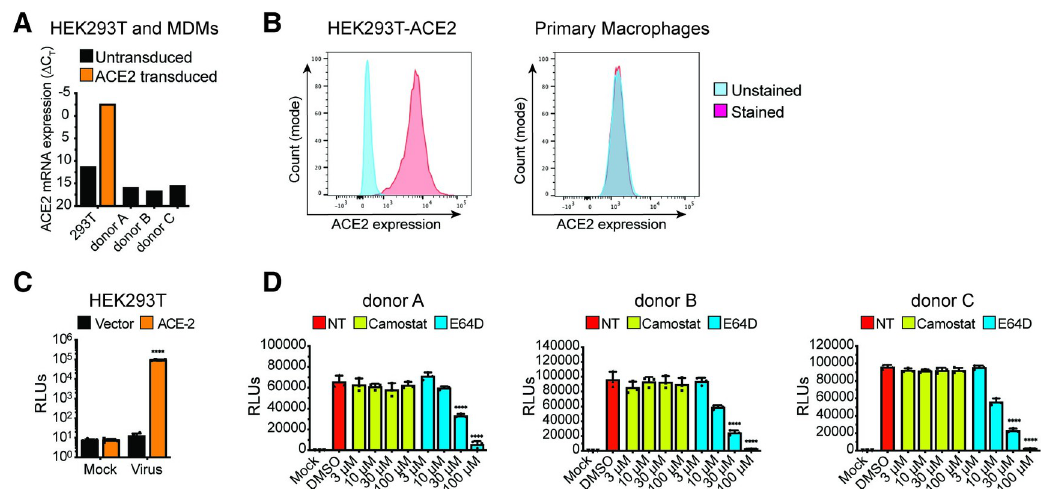
Fig 1. ACE2-independent SARS-CoV-2 entry in macrophages. ( A - B ) Representative ACE2 mRNA expression ( A ) and flow cytometry profiles showing ACE2 surface expression ( B ) of HEK293T cells stably expressing ACE2 and primary MDMs from multiple donors. ( C - D ) Parental (vector) and transduced (ACE2) HEK293T cells ( C ) and primary MDMs from 3 donors ( D ) were infected with S-pseudotyped lentivirus (20 ng based on p24 Gag ), in the absence or presence of cathepsin inhibitor (E64D) or TMPRSS2 inhibitor (Camostat), and infection was quantified by measuring luciferase activity at day 3 post-infection. Mock: no virus added, DMSO: no-treatment. The means ± SEM from at least 3 independent experiments are shown. P -values: paired t-test, two-tailed comparing to vector control ( C ), or one-way ANOVA followed by the Dunnett’s post-test comparing to DMSO ( D ). ���� : p < 0.0001.